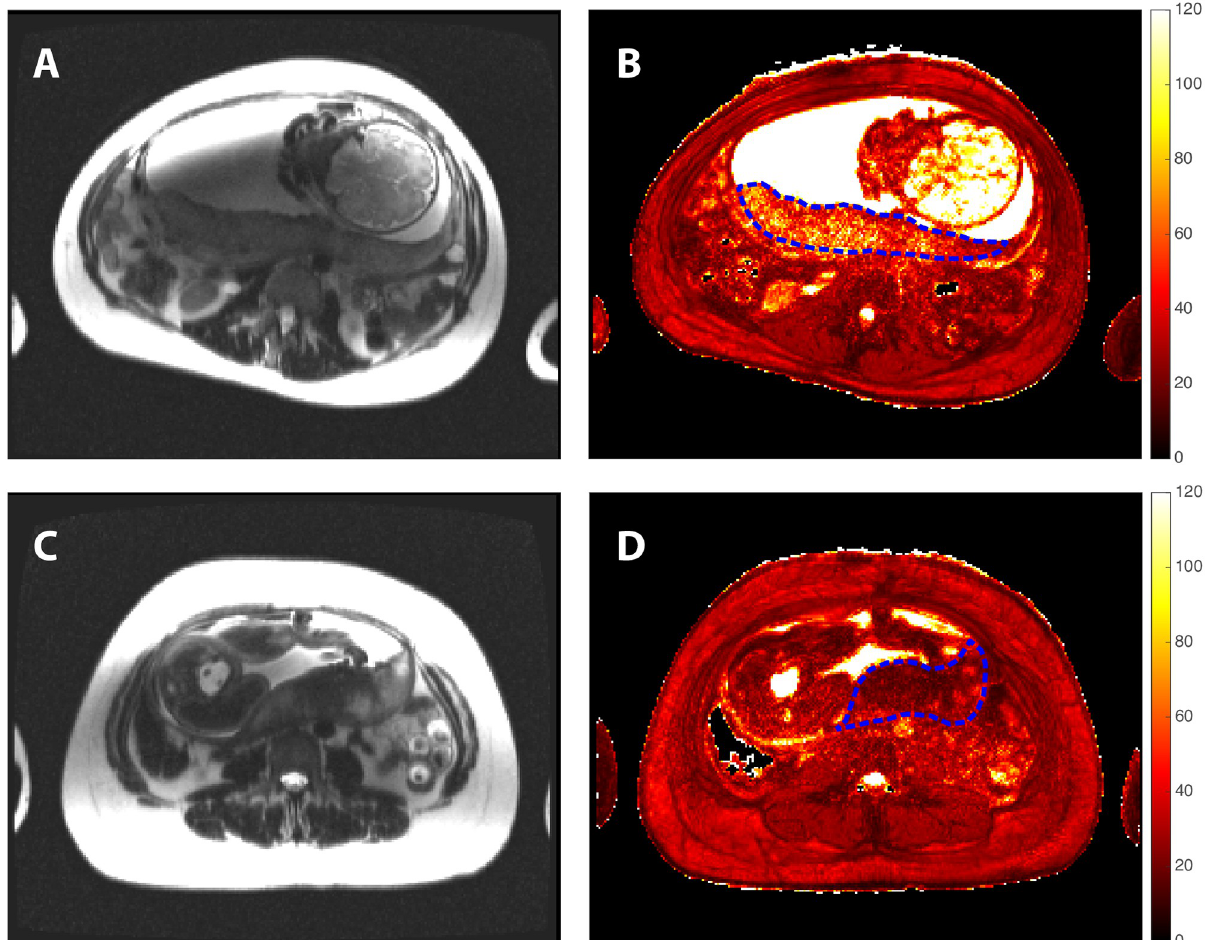
Fig 3. Comparison of anatomic magnetic resonance imaging and placental T2 � mapping in uncomplicated normal and primary adverse pregnancies. T2-weighted HASTE MRI (left column) and placental T2 � maps (right column) are shown for an uncomplicated normal pregnancy at 232 days gestation (top row, panels A & B) and for a primary adverse pregnancy at 235 days gestation presenting with severe preeclampsia (bottom row, panels C & D). The placenta is indicated by the dashed blue outlines overlaid on the T2 � maps. (= 51 ms) close to the population median (50th percentile), while the bottom row shows corre- sponding images for a PA pregnancy at 235 days gestation with a median T2 � (= 26 ms) in the 1st percentile. Depression of the placental T2 � in the latter is clearly apparent in panel D.